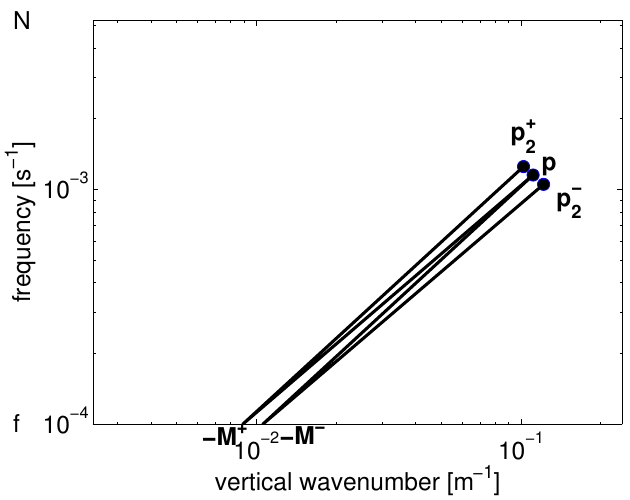
Figure 2. Resonant configuration of the two triads completing the balance for p , [ ( m , M , m − M ) , ( k ,0, k ) , ( σ , f , kN ) ] and [ ( m , M , m + M ) , ( k ,0, k ) , ( σ , f , kN ) ]. The two are distinguished with m − M m + M superscripts of ± according to the sign of ± f . The wavenumber for p 1 = ( 0,0, m 1 ) in the reduced model under discussion, and is denoted as ( 0,0, M ± ) at resonance. The low dimensional example in Section 3.1 employs one of these